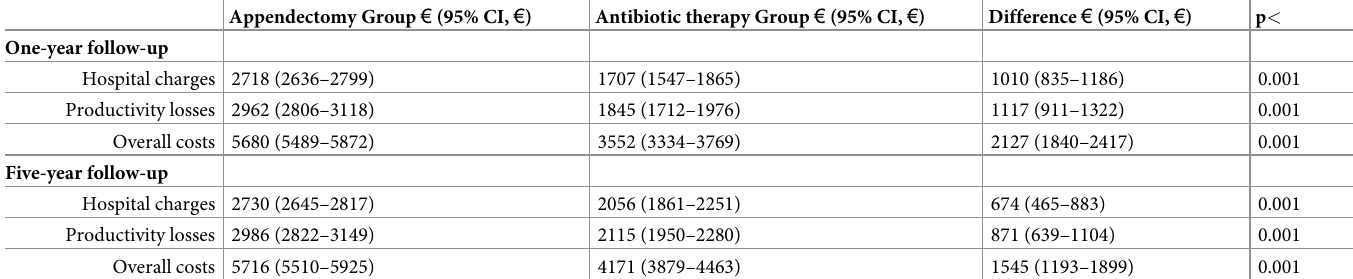
Table 1. Mean hospital charges, productivity losses and overall costs in Euros per patient for appendectomy and antibiotic therapy group patients with uncompli- cated acute appendicitis at five-year follow-up. Appendectomy Group € (95% CI, € )